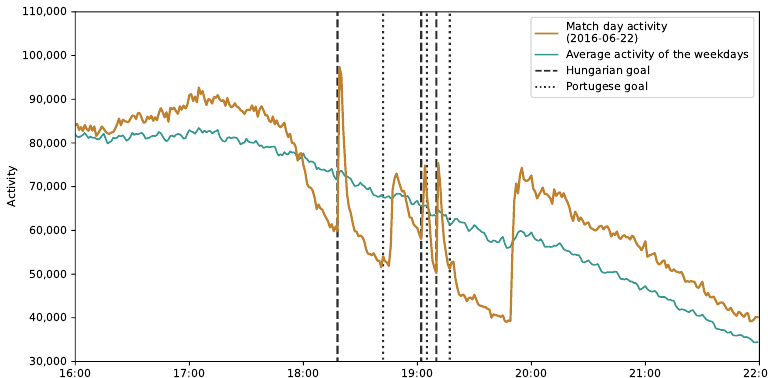
Figure 11. Mobile phone activity during and after the Hungary–Portugal Euro 2016 match in com- parison with the average activity on weekdays.